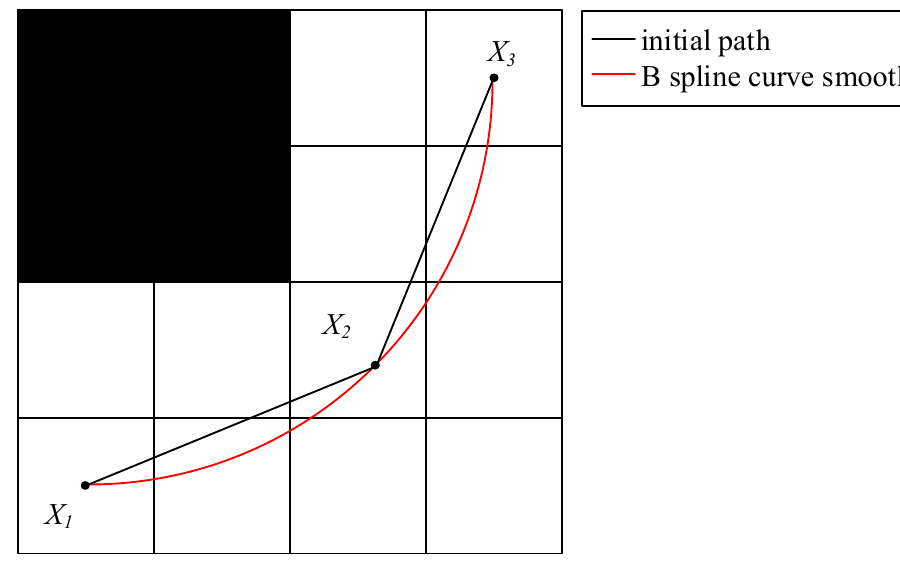
Figure 3. B spline curve theory.